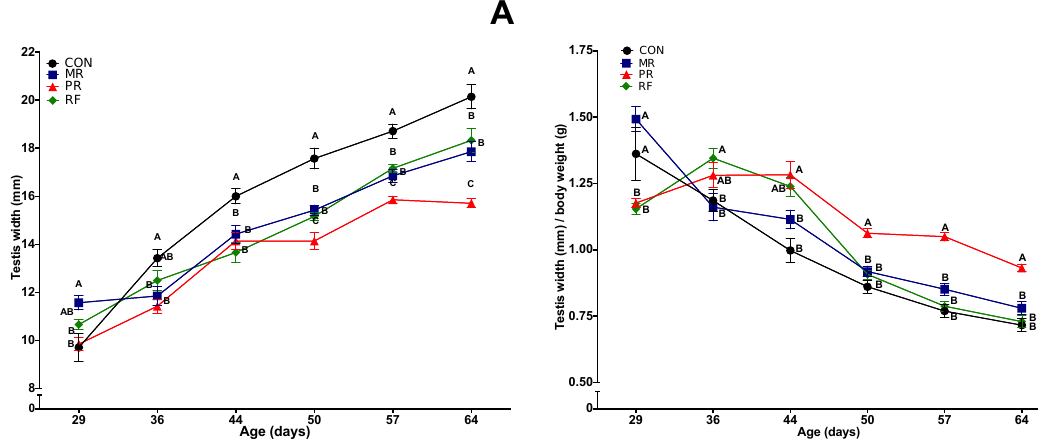
Figure 3. Mean ( ± SEM) e ff ects of feed restriction and refeeding on testes width (absolute ( A ) and relative to body weight ( B )) in rats ( n = 8 / group). CON (Control), ad libitum feeding; MR (Mild Restriction), 75% of CON intake; PR (Profound Restriction), 50% of CON intake; and RF (Refeeding group), 50% of CON intake for 14 days, and then ad libitum. Treatment, time and treatment by time interaction were significant ( p < 0.001) for both end points. A–C Within a day of age, groups without a common superscript di ff ered ( p < 0.05).